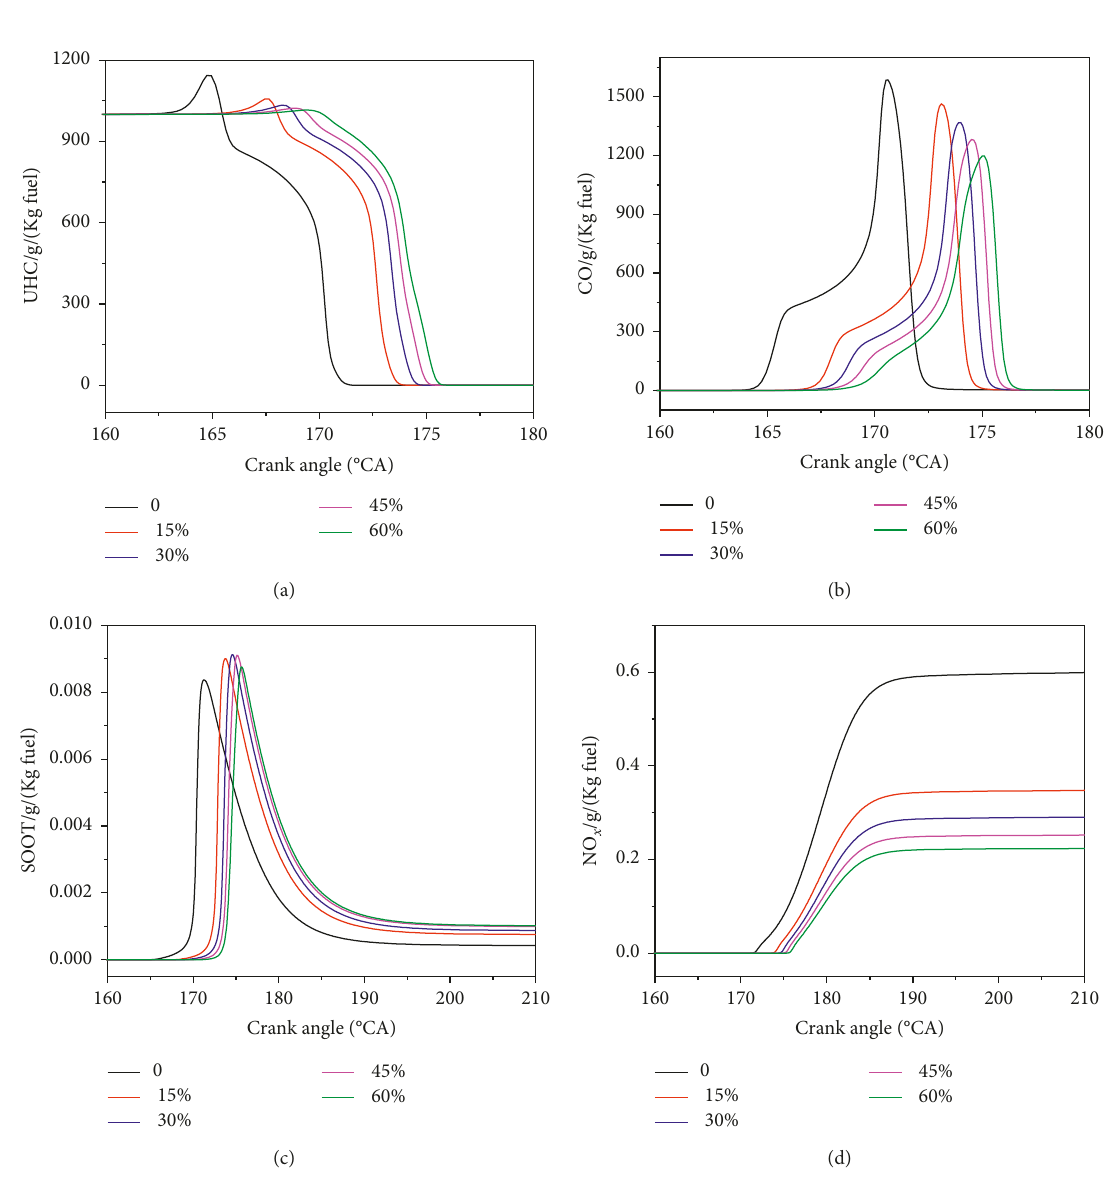
Figure 6: The emission performance of different n -butanol